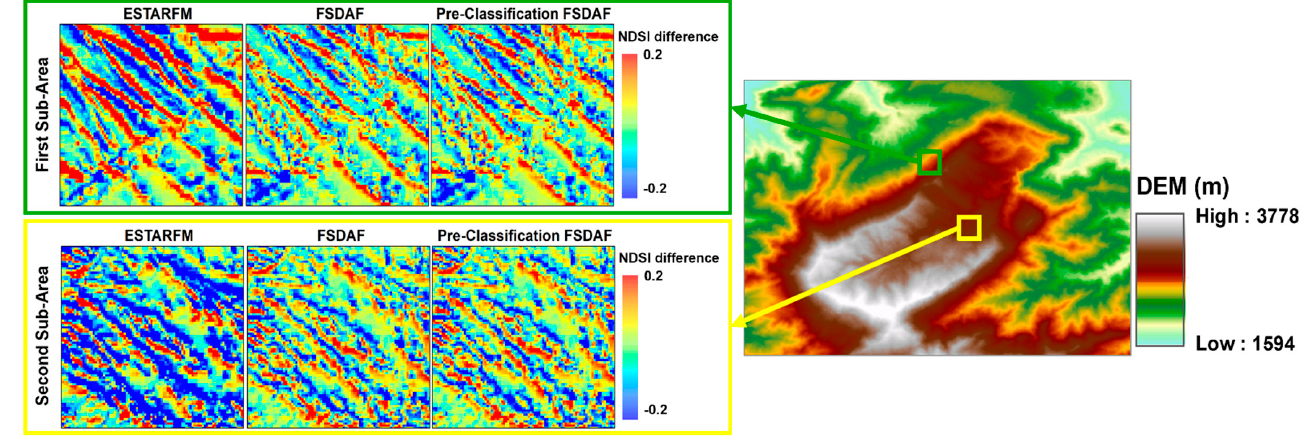
Figure 10. Difference between actual NDSI S2 image and NDSI images predicted by the three fusion models over the two subareas. Table 2. The unaltered areas between the real NDSI S2 image and the NDSI images predicted by the three fusion models over.